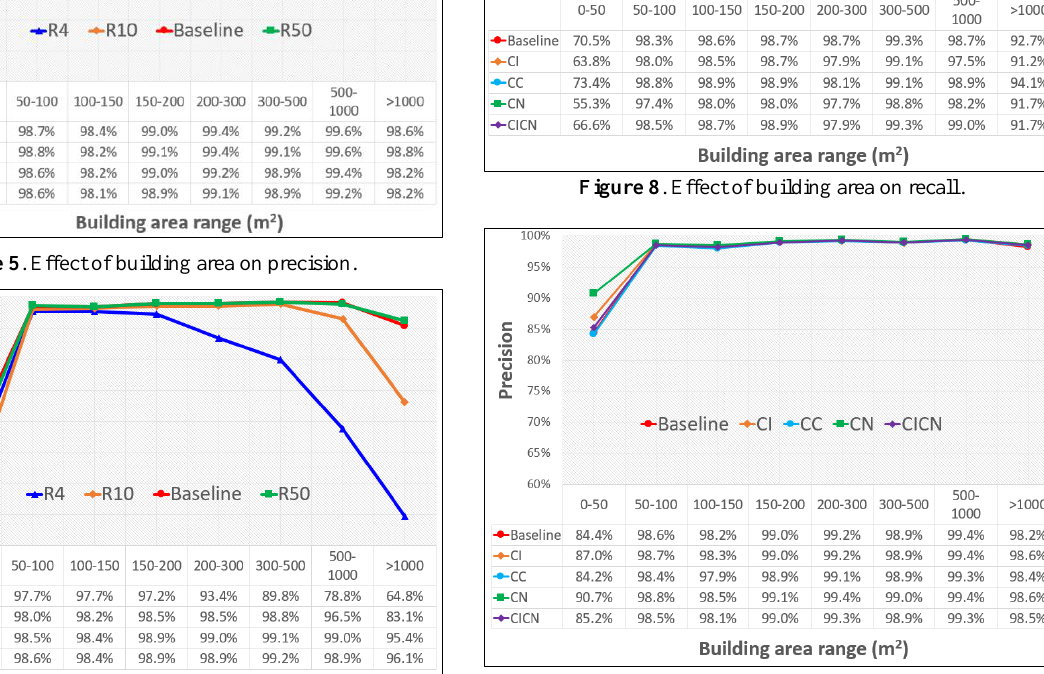
Figure 9 . Effect of building area on